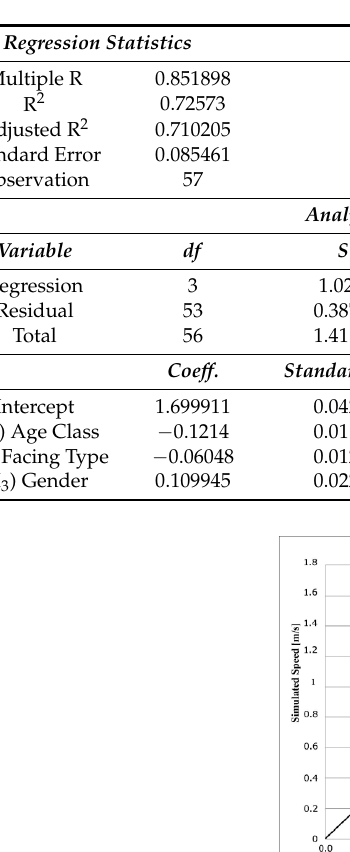
Table 3. Global model: regression statistics and ANOVA.